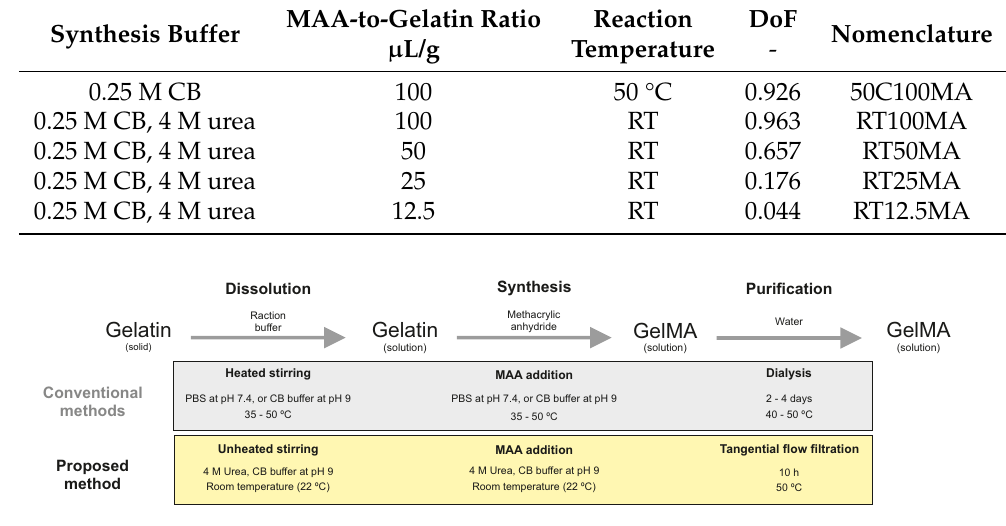
Figure 1. Synthesis and purification of gelatin methacryloyl (GelMA). Conventional methods